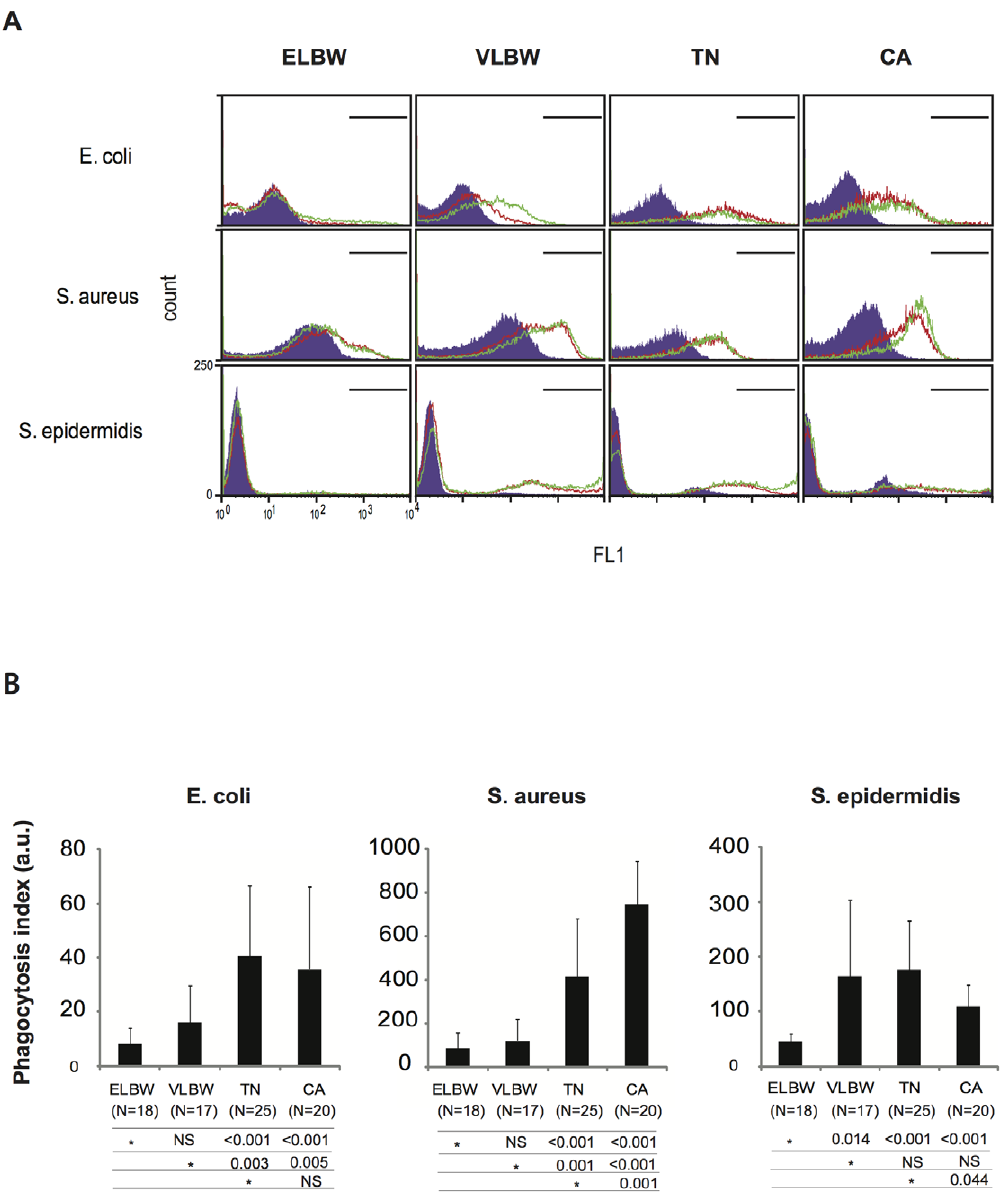
Figure 2. Phagocytosis of bacteria by newborn and adult neutrophils, and plasma opsonic activity. (A) Phagocytosis of fluorescent E.coli , S.aureus , and S.epidermidis by neutrophils from one representative subject from each group (ELBW, extremely low birth weight premature infants born before 28 wks of gestational age; VLBW, very low birth weight premature infants born between 28–32 wks of gestational age; TN, term newborns; and CA, control adults). Phagocytosis was measured by flow cytometry after 10 min (red lines) and 20 min (green lines) incubation with bacteria opsonised with autologous plasma. Neutrophils pre-incubated with the phagocytosis blocker cytochalasin D are presented with filled curves (negative control). (B) The opsonic capacity of patient’s plasma using neutrophil-like human HL-60 cells is tested. Fluorescent E.coli , S.aureus , and S.epidermidis were opsonised with autologous plasma and incubated 40 min with DMSO-differentiated HL-60 cells. Intracellular fluorescence (phagocytosis of bacteria) was measured by flow cytometry and expressed as mean phagocytic index ( 6 SEM) of the four groups (ELBW, extremely low birth weight premature infants born before 28 wks of gestational age N=21; VLBW, very low birth weight premature infants born between 28– 32 wks of gestational age, N=24; TN, term newborns, N=25; CA, control adults, N=20). On each line, a reference group (*) is compared to other groups and respective P value expressed using Mann-Whitney U test.